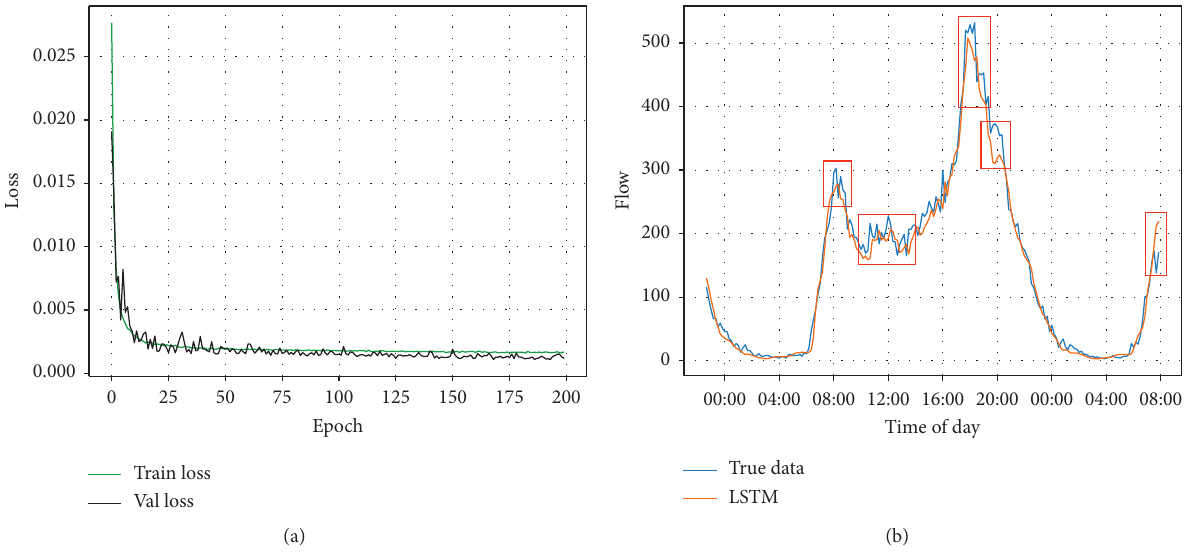
Figure 3: 10min LSTM training and prediction. (a)10min LSTM loss function and (b) 10min LSTM prediction